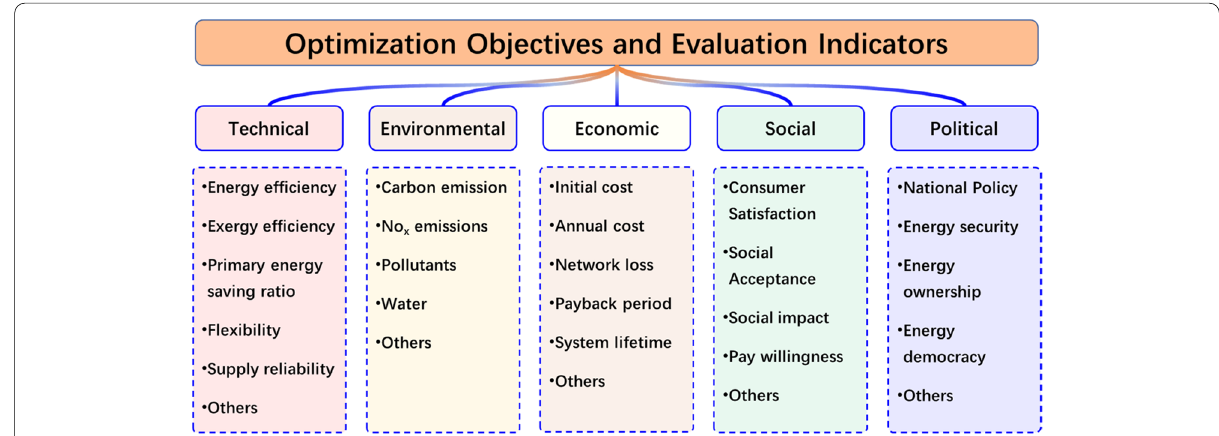
Fig. 8 Optimization objectives and evaluation indicators of distributed energy